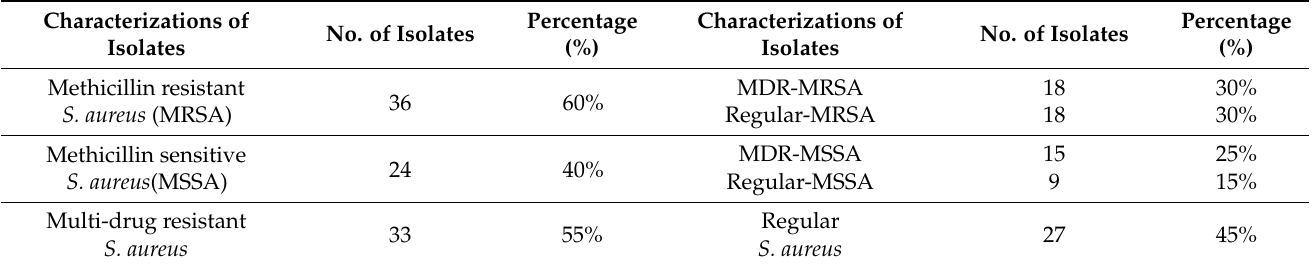
Table 2. Characterization of different types of S. aureus in the clinical isolates ( n = 60).